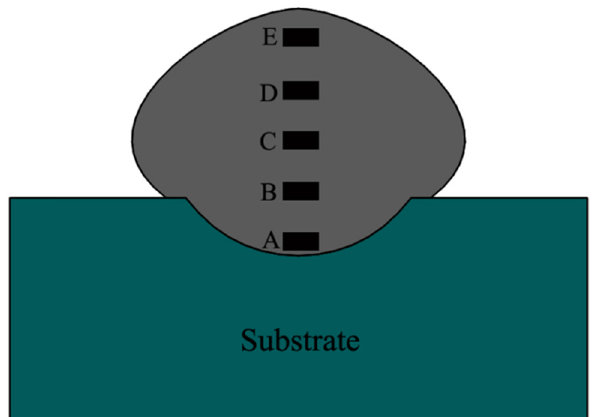
Figure 5: Schematic of sampling areas used in energy spectrum